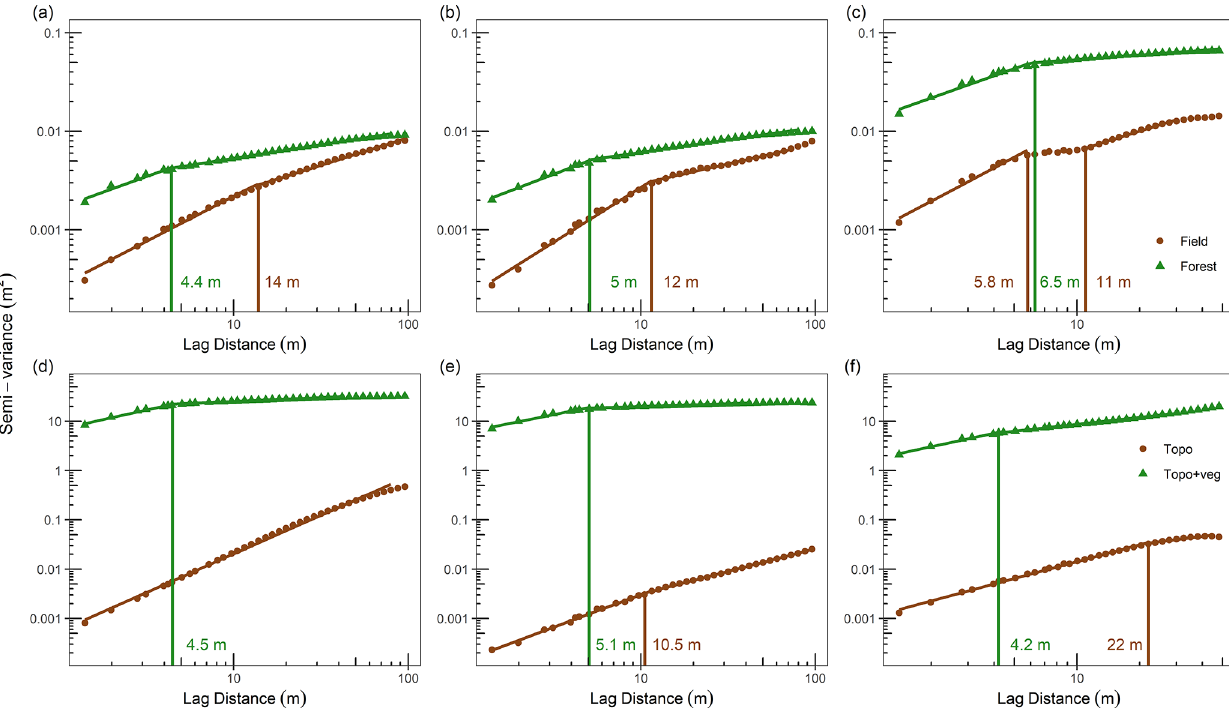
Figure 5. Omnidirectional semi-variogram for the field and forested areas for (a) Sainte-Marthe snow depth, (b) Saint-Maurice snow depth, (c) Montmorency snow depth, (d) Sainte-Marthe bare-earth topography and topography + vegetation, (e) Saint-Maurice bare-earth topog- raphy and topography + vegetation, and (f) Montmorency bare-earth topography and topography + vegetation. In the figure, Topo denotes bare-earth topography and Topo + veg denotes topography + vegetation surface. Vertical lines indicate the dominant scale breaks, and trend lines represent significant ( p < 0.05) log–log linear models with R 2 > 0.9 (see